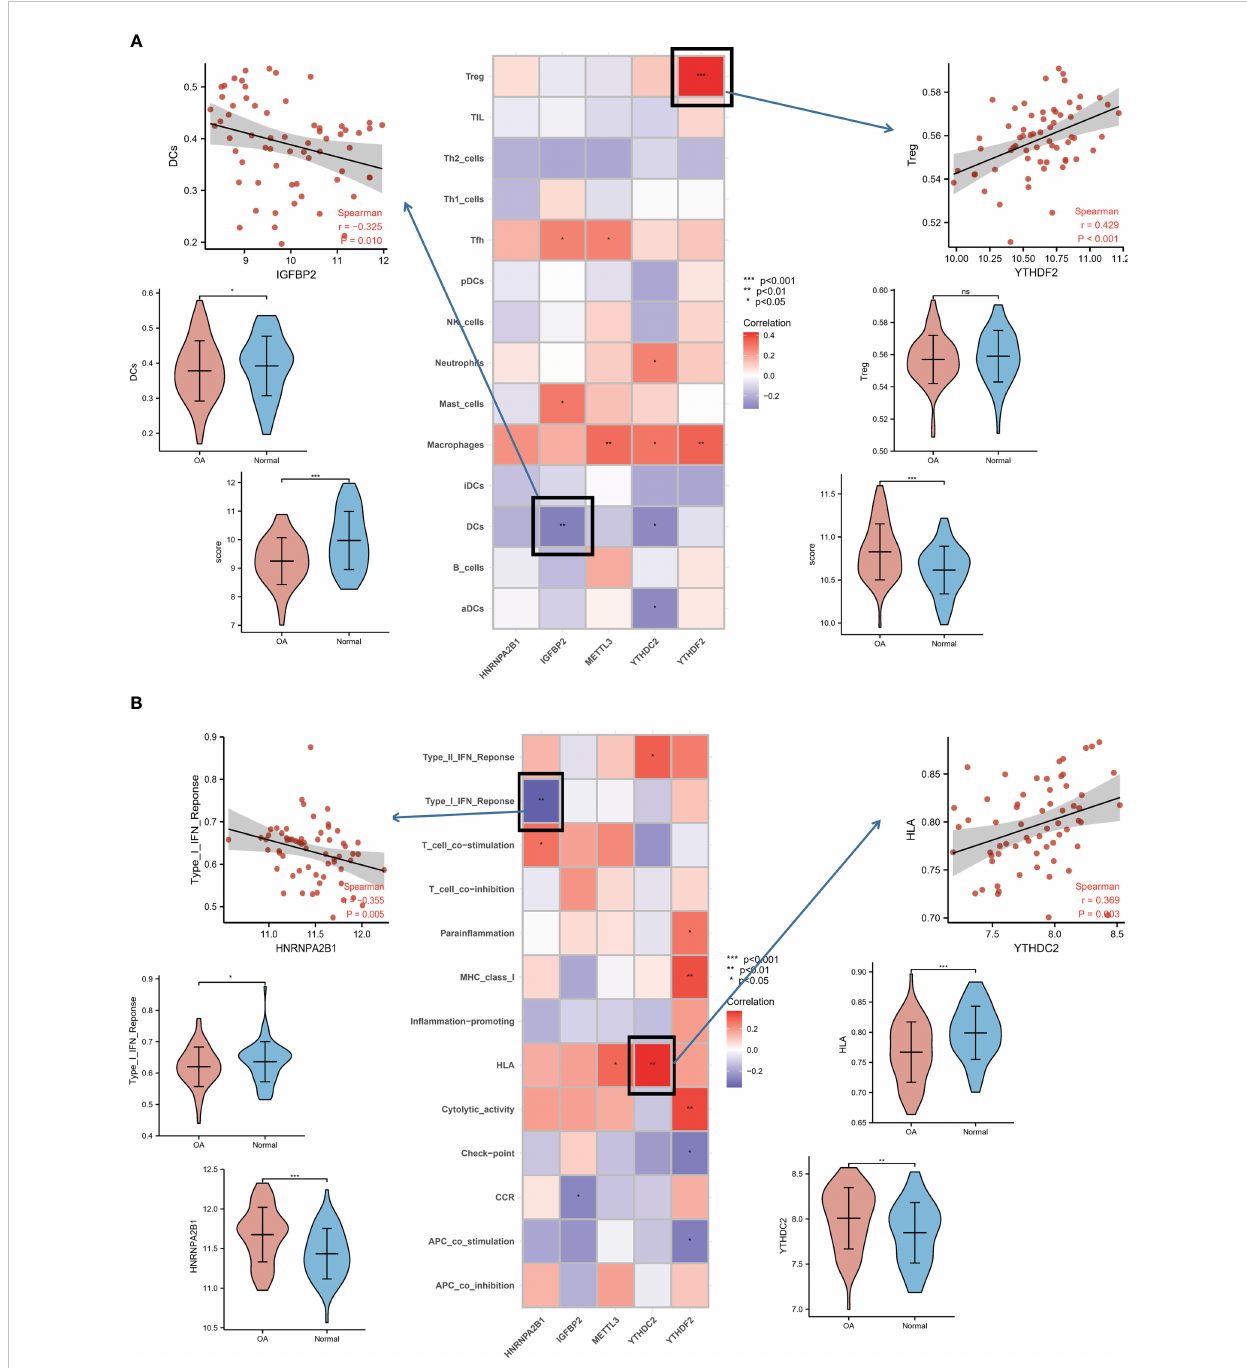
FIGURE 4 Relationship analysis of m6A regulators with immune characteristics in OA. (A) Dot plot showing the relationship of in fi ltrating immune cells with hub m6A regulators in the OA immune microenvironment. The most positively related immunocyte-m6A regulator pair is YTHDF2-Treg cell (r = 0.429), and the most negative is IGFBP2-DC cell (r = -0.325), with expression and fraction status presented in the upper panel. (B) Dot plot showing the relationship of immune response pathways with hub m6A regulators in the OA immune microenvironment. The most positively associated pair is the YTHDF2-HLA pathway (r = 0.369), the most negatively correlated is HNRNPA2B1-Type I IFN response (r = -0.355), with the violin plot in the bottom panel showing expression or